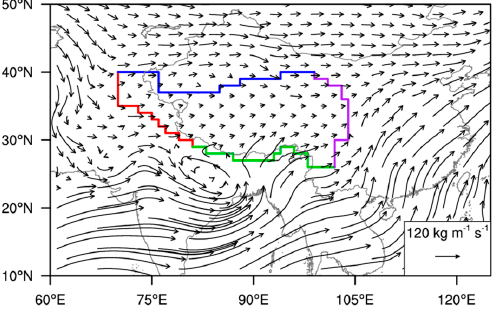
Figure 2. Climatological mean of vertically integrated water vapor fluxes (vectors; units: kg m − 1 s − 1 ) in summer from 1979 to 2019.